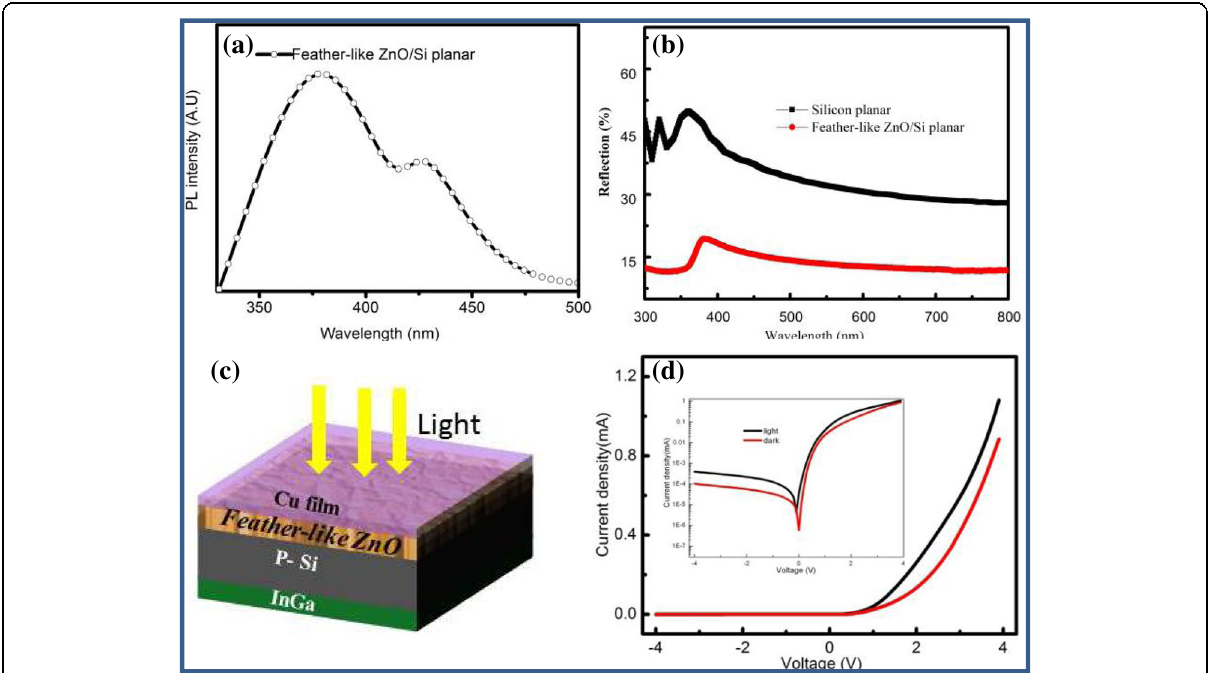
Fig. 5 a PL spectrum of feather-like ZnO. b Reflection spectra of ZnO/Si and Si planar. c The schematic of feather-like ZnO/Si photo-diodes. d I - V curves of feather-like ZnO/Si; the inset of d is the lnI- V